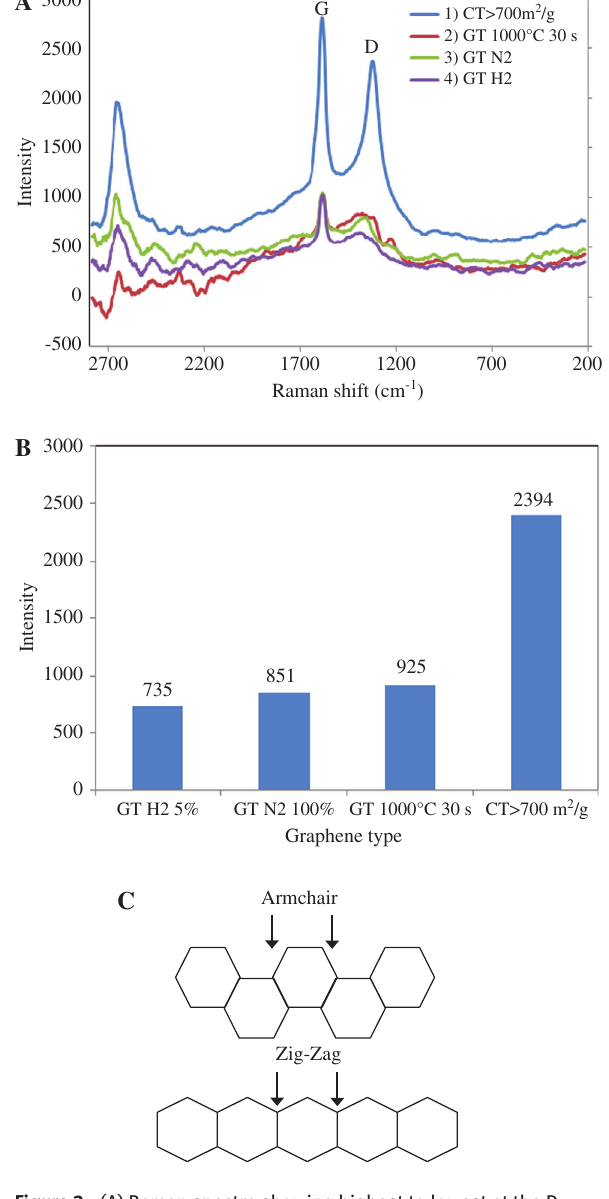
Figure 3 (A) Raman spectra showing highest to lowest at the D peak (smoothed using 15-point moving average), (B) comparing D peak intensity of graphene produced using four different methods (intensities compared using unsmoothed data), and (C) graphene edges zigzag and armchair.